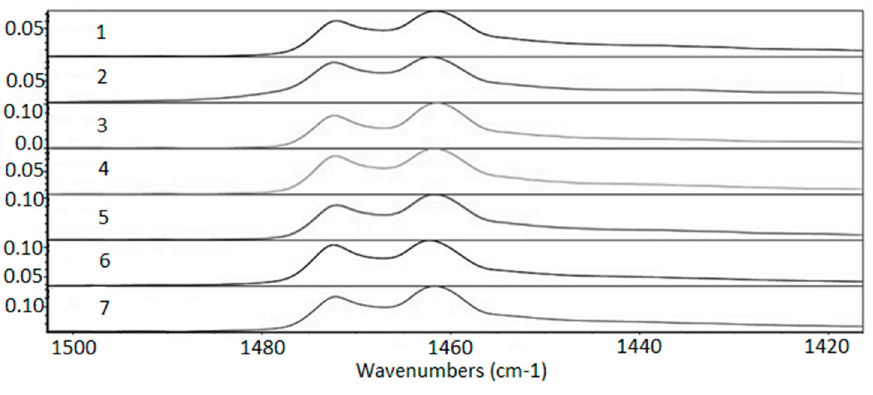
Figure 8. Absorption spectra region from 1420 to 1500 cm − 1 . 1—virgin sample; 2—960 h Xenon arc